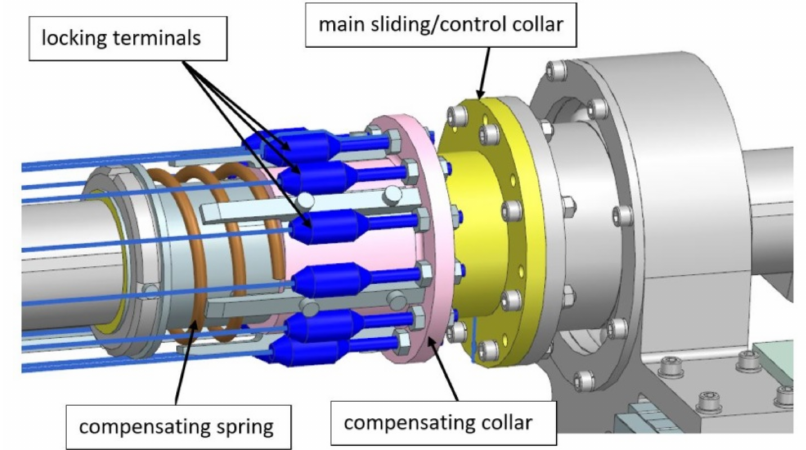
Figure 9. View of the rope tensioning